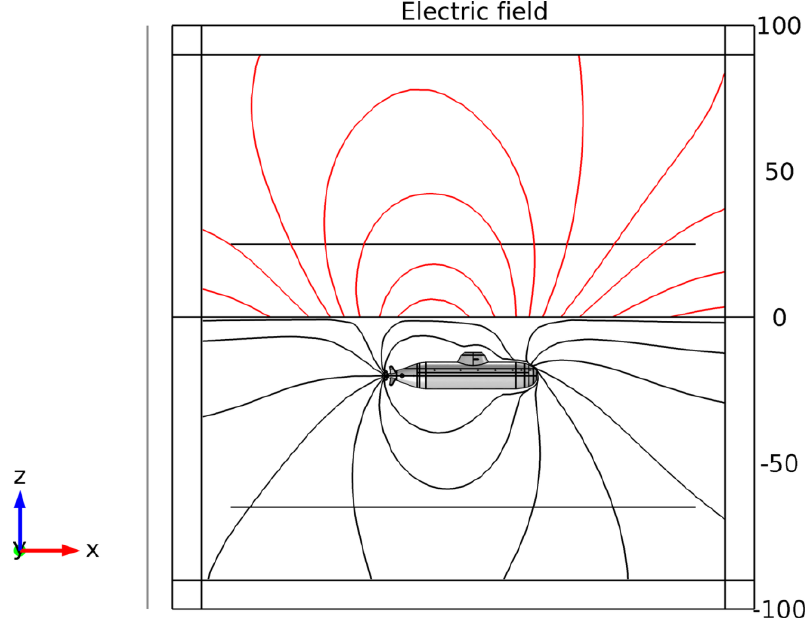
Figure 10. Numerically simulated electric field lines for a submarine model. The distance between the field lines does not represent the electric field strength, because the seeding points for the field lines were set manually.